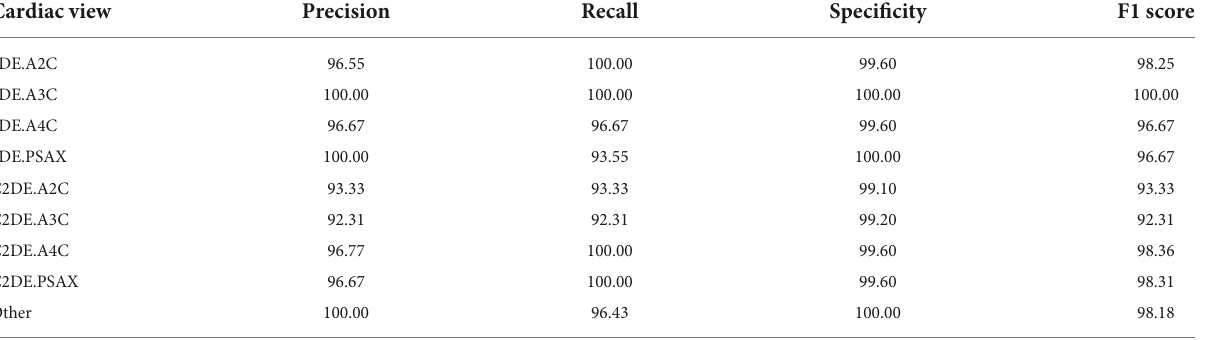
TABLE 4 The results of view classification on the test